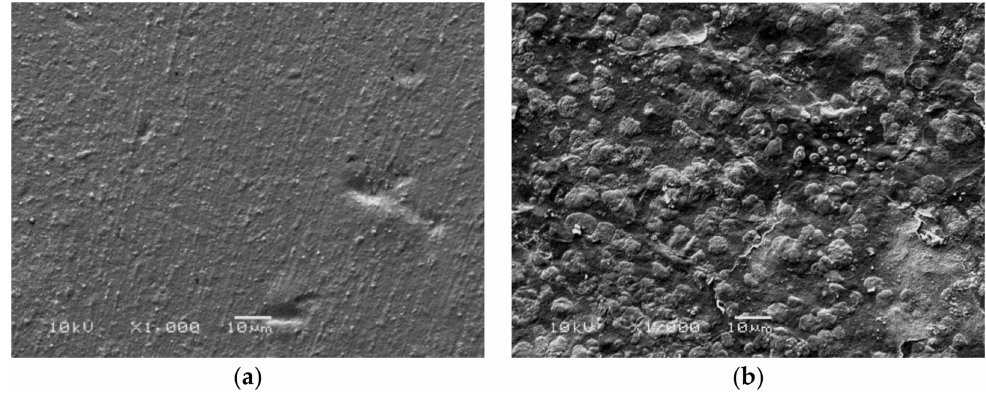
Figure 2. SEM images of ( a ) Ch/HA and ( b ) Ch/HA/MitoQ membranes.